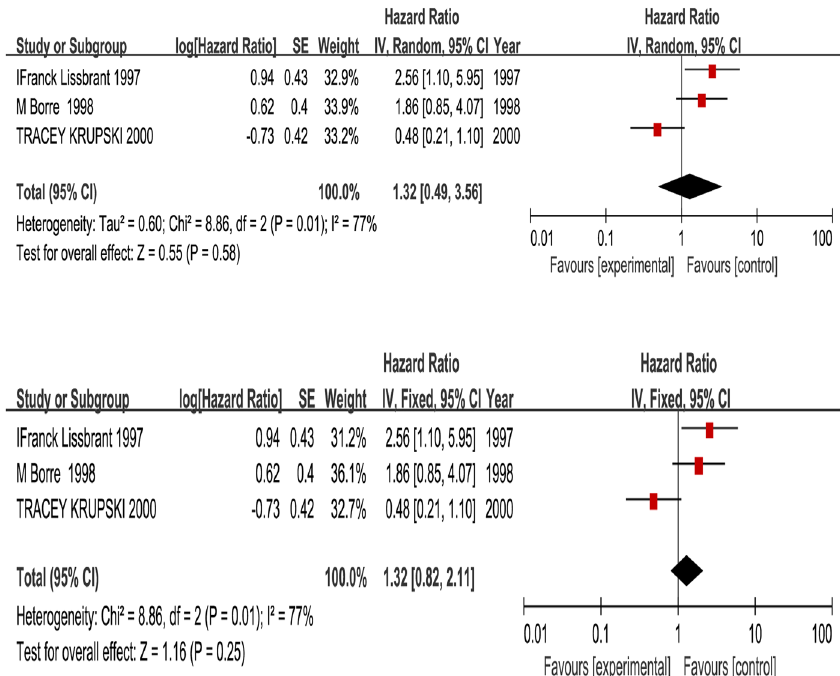
Figure 4: Meta - analysis ( forest plot ) of 3 eligible studies assessing ( microvessel density ) MVD in DSS of prostate cancer patients. The pooled HR ( its 95% CI ) for DSS is 1.32 ( 0.49, 3.56 ) . Each study is shown by the fi rst author/year and the HR with 95% CI.